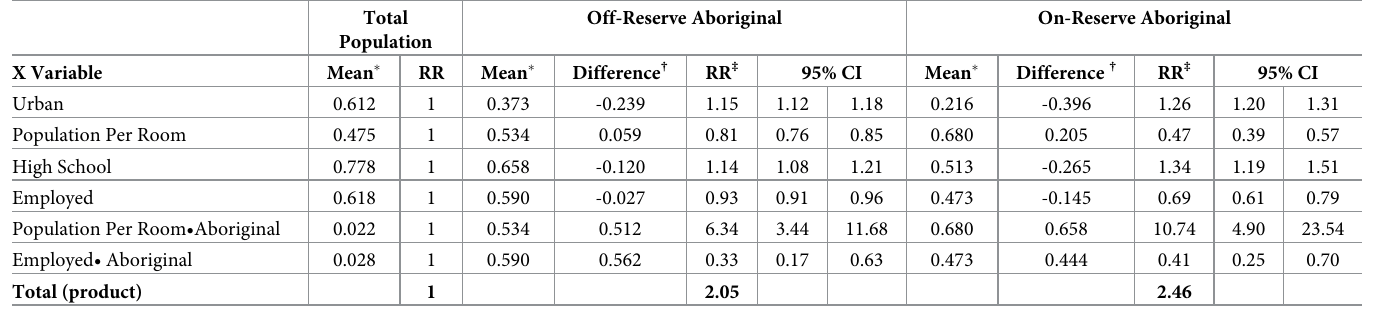
Table 9. Relative risks predicted by the best-fitting multivariable regression